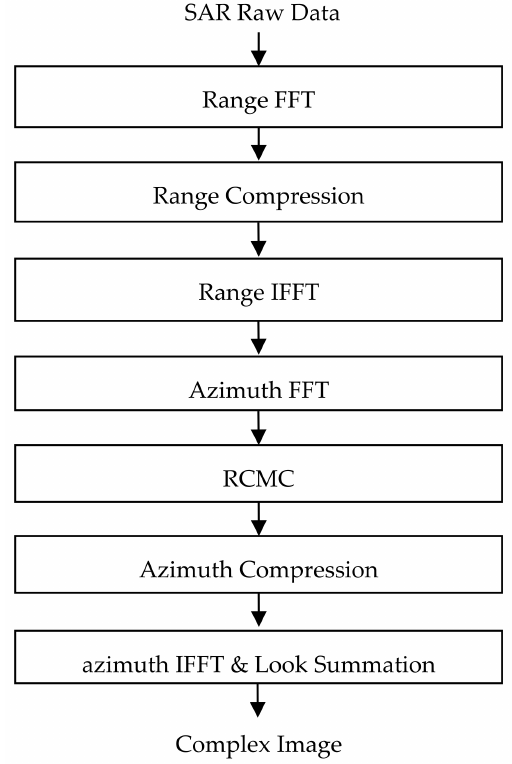
Figure 2. RDA block